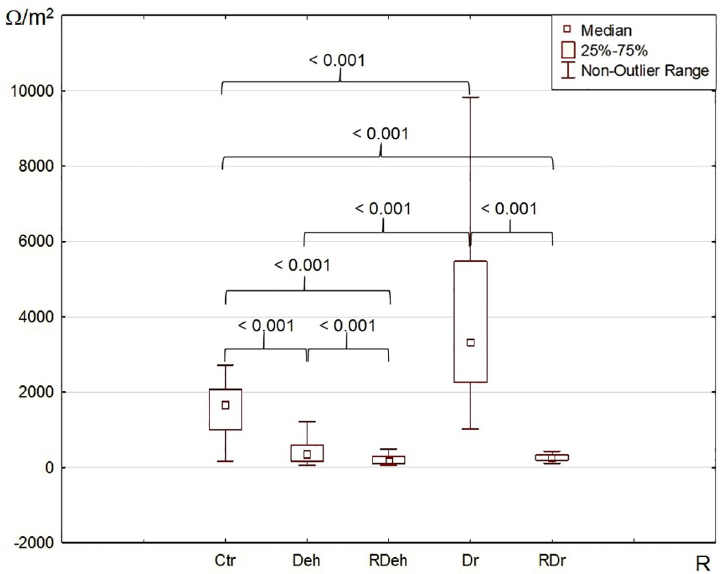
Fig 2. The transepithelial resistance (R, O /cm 2 ) measured in stationary conditions of the isolated rabbit skin specimens incubated in Ringer’s solution (RH), pre–treated as follows: Ctr (control: skin specimens incubated in RH for 30 min), Deh (dehydrated: skin specimens incubated in 10% NaCl for 30 min), RDeh (rehydrated after dehydration: skin specimens rehydrated in RH for 30 min after incubation in 10% NaCl for 30 min), Dr (dried: skin specimens dried at 37˚C for 60 min), RDr (rehydrated after drying: skin specimens rehydrated in RH for 60 min after drying at 37˚C for 60 min). The p values < 0.05 were considered as statistically significant.